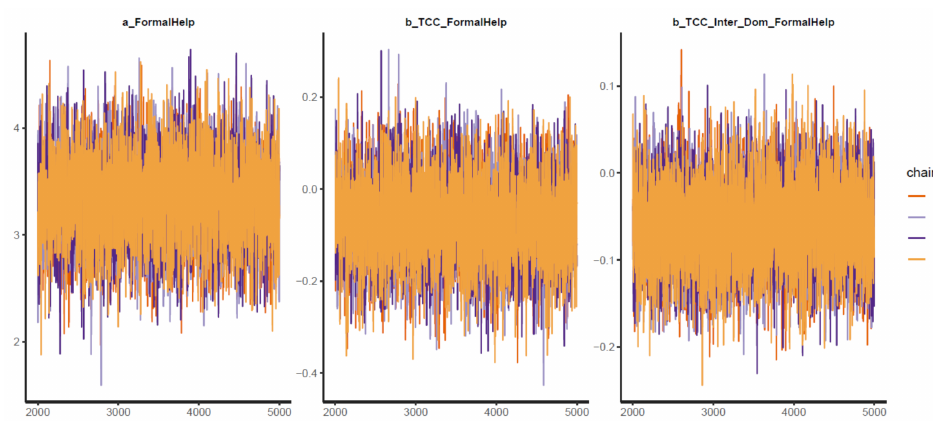
Figure 13. Trace plots for Model 3 (cid:48) s posterior coefficients.